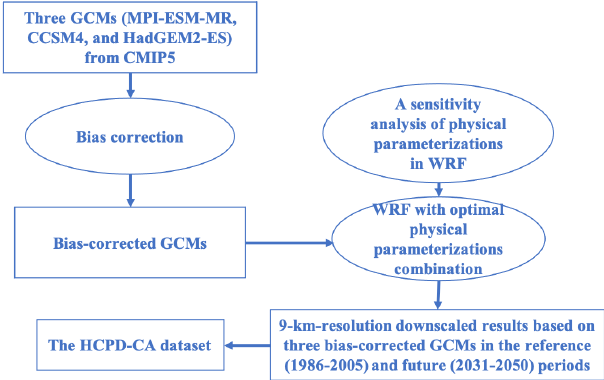
Figure 2. Flow chart for the HCPD-CA